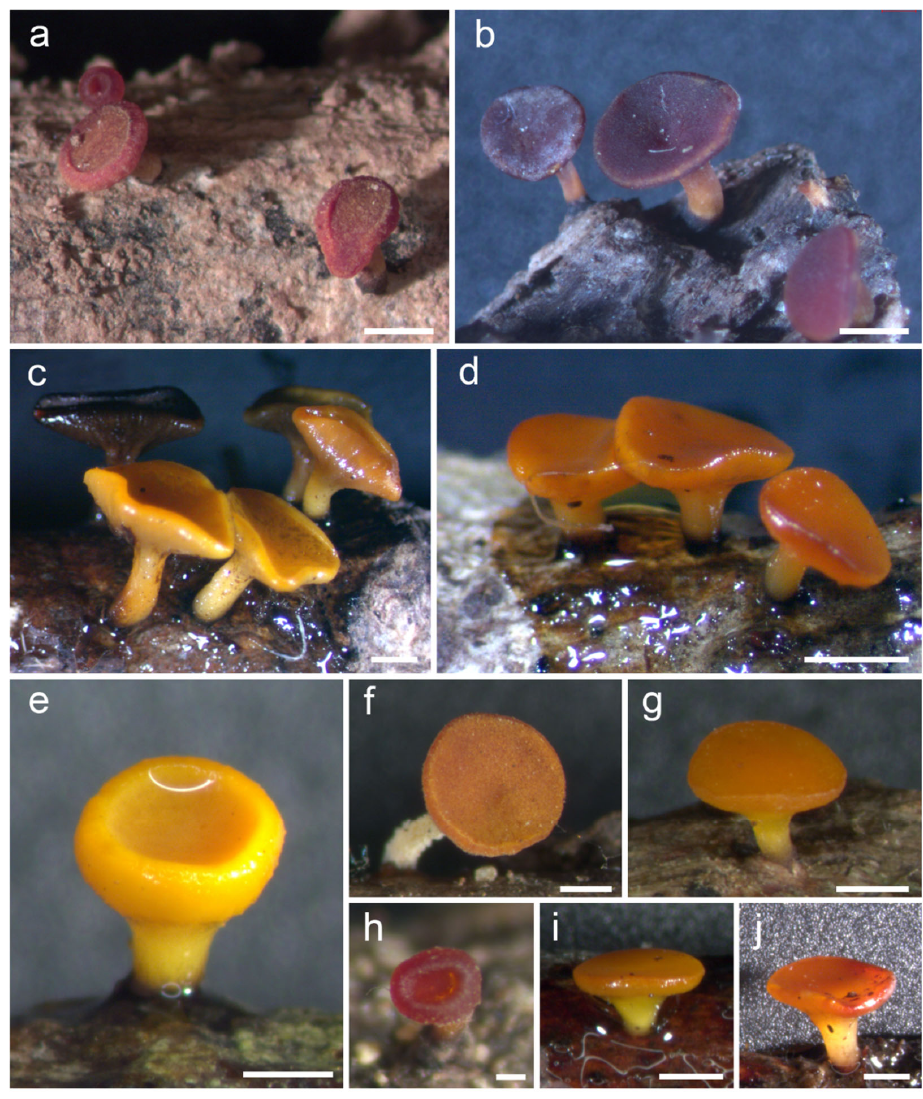
Figure 8. Apothecial diversity in Dicephalospora rufocornea . ( a , b , f , h ) Dry apothecia on wood; ( a ) MFLU 19 ‐ 2071; ( b ) MFLU 19 ‐ 2073; ( f ) MFLU 19 ‐ 2085; ( h ) MFLU 19 ‐ 2082; ( c – e , g , i , j ) fresh apothecia on the substrate; ( c , d ) MFLU 19 ‐ 2083; ( e ) MFLU 19 ‐ 2082; ( g ) MFLU 19 ‐ 2085; ( i ) MFLU 19 ‐ 2087; ( j ) MFLU 19 ‐ 2089. Scale bars: ( a , e – g , i ) = 0.5 mm; ( b – d , j ) = 1 mm; ( h ) = 0.2 mm.